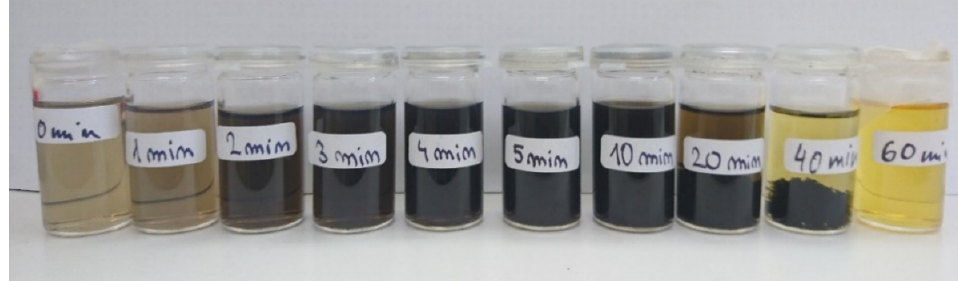
Figure 1. Optical photograph of pristine and laser treated H-DNDs in ethanol up to 60 min.